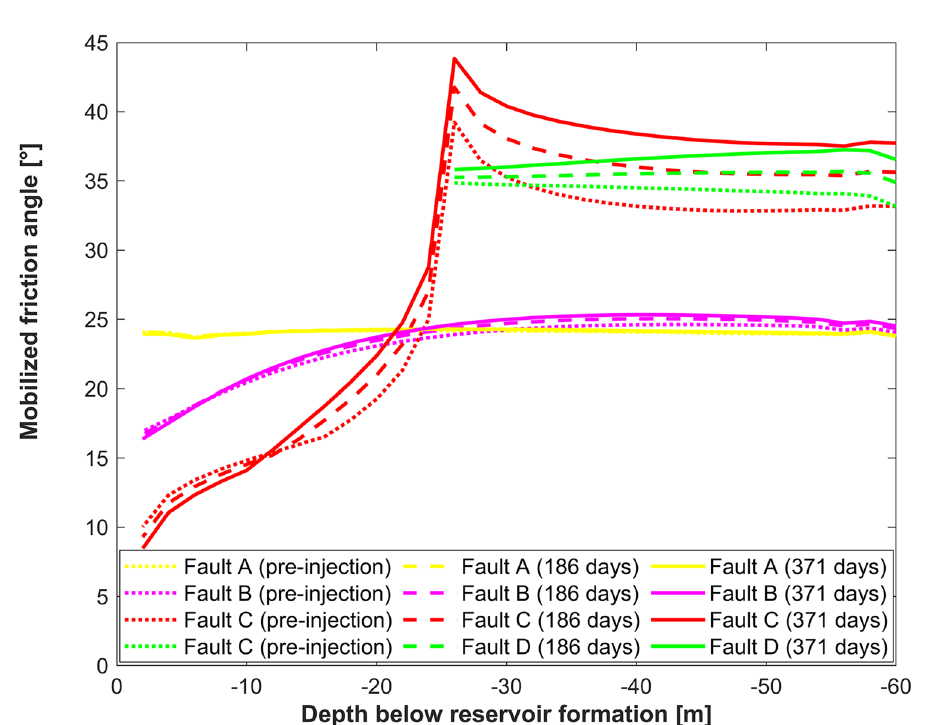
Figure 8. Mobilized friction angle along the faults at different moments of time. Depth of -60 m represents the deepest boundary of the model, depth of 0 m represents the interface between Mt. Simon sandstone and Precambrian/Argenta